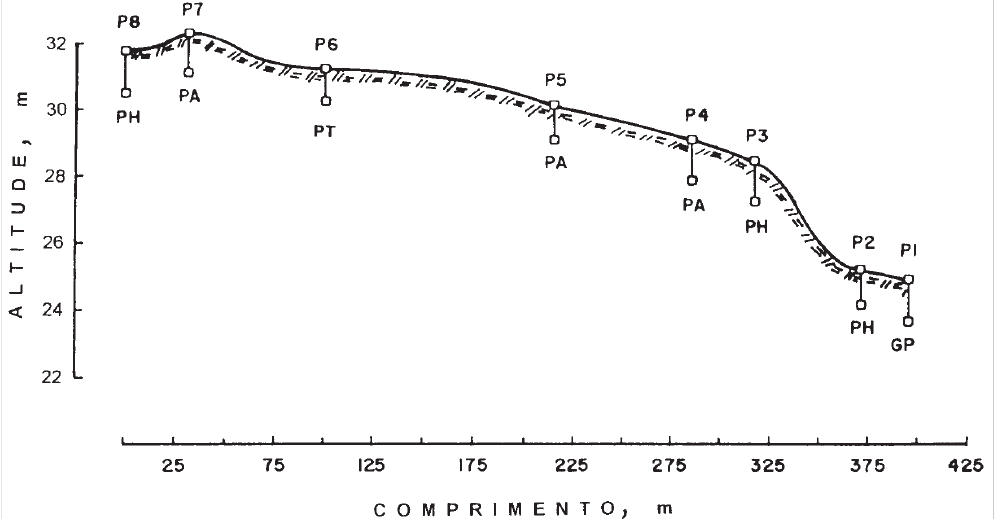
Figura 1. Localização dos perfis na toposseqüência. PH = Podzol Hidromórfico, PA = Podzólico Amarelo, PT = Plintossolo, GP = Gley pouco